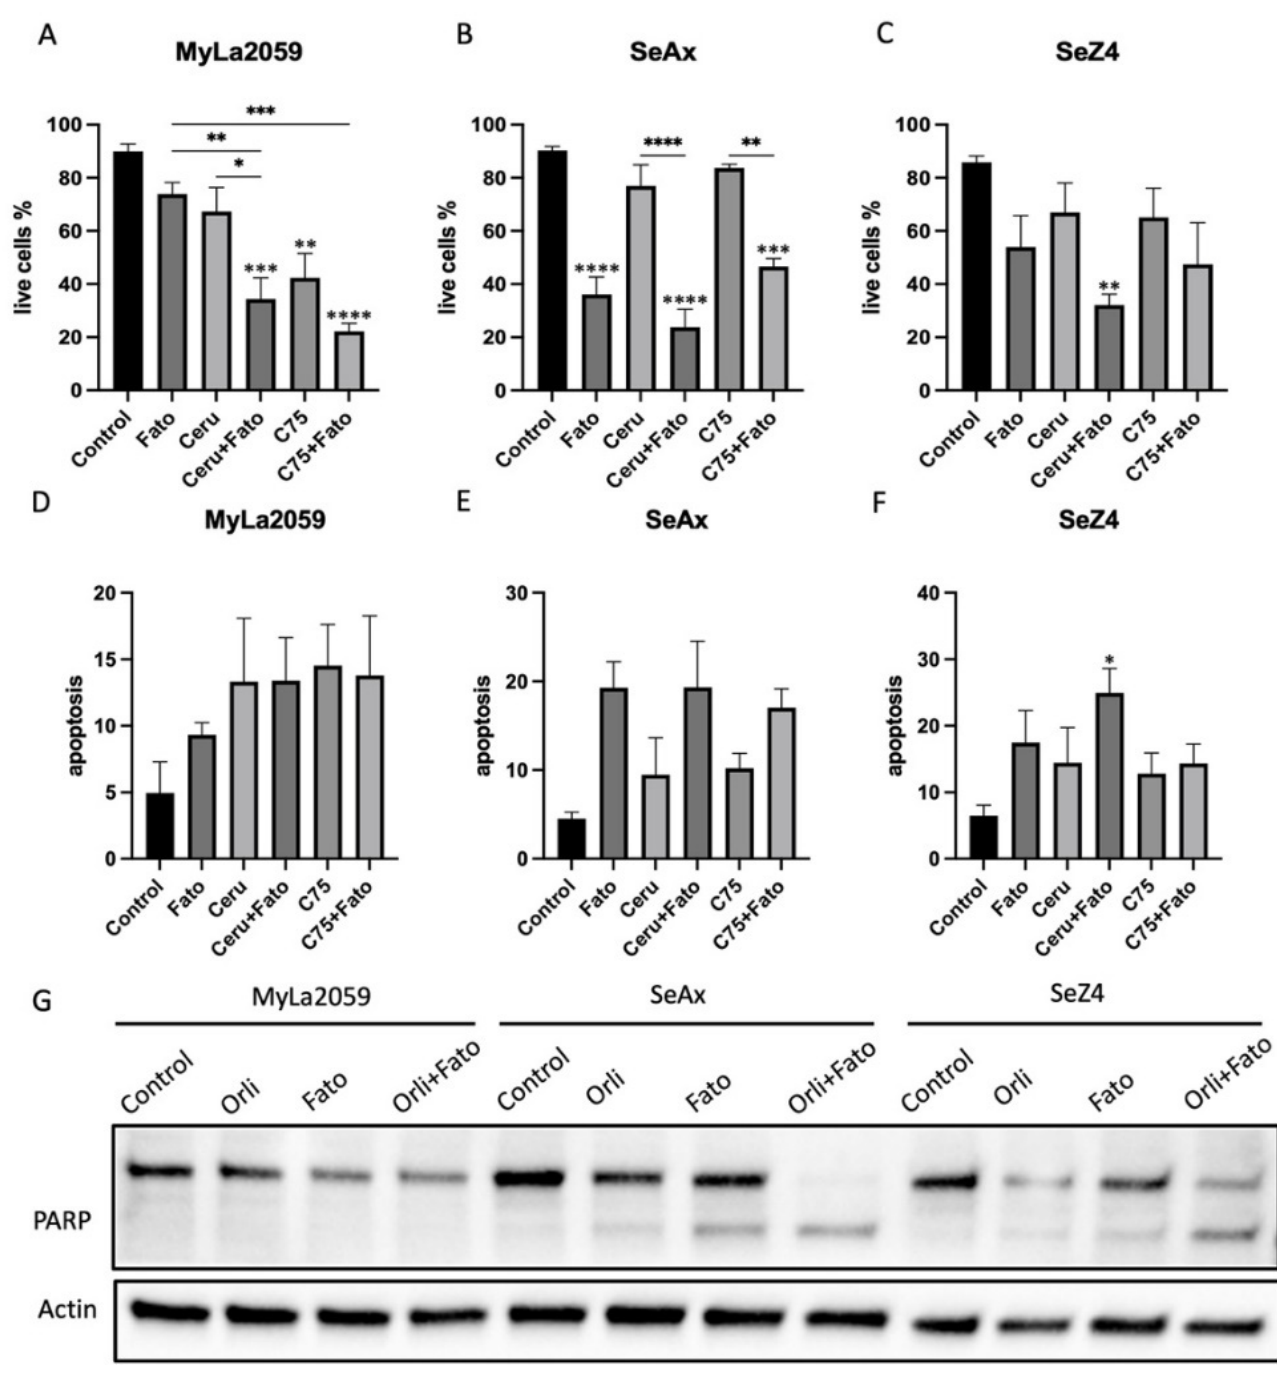
Figure 4. SREBP and FASN inhibitors attenuated cell survival and induced apoptosis in CTCL cell lines. ( A – C ) Cell survival analysed by flowcytometry showed damaged cell survival by Fatostatin, Cerulenin, and C75 in MyLa2059, SeAx, and SeZ4, with more effects in the combination group. ( D – F ) Apoptosis evaluated by both flowcytometry and ( G ) western blot exhibited similar